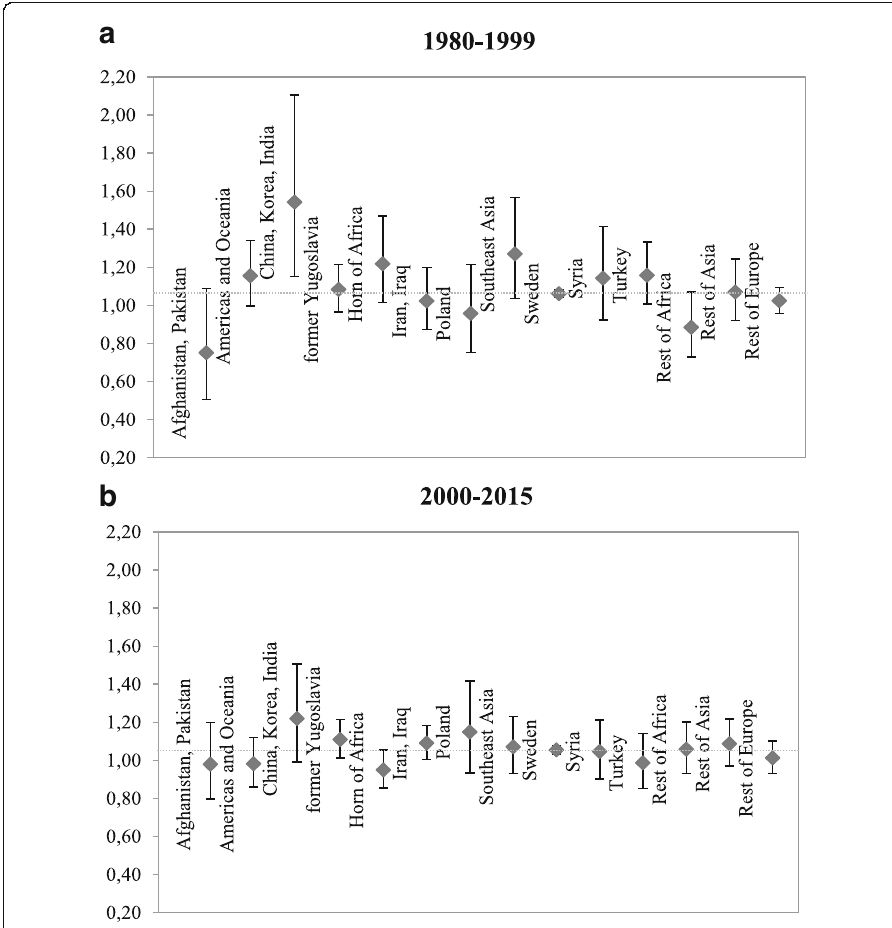
Fig. 1 Sex ratio at birth, third births, mothers who had two daughters, by country/region of birth of the mother, over calendar time, Sweden. a 1980 – 1999. b 2000 – 2015. Notes: The dotted line indicates sex ratio at birth equal to 1.06 Source: Swedish registers